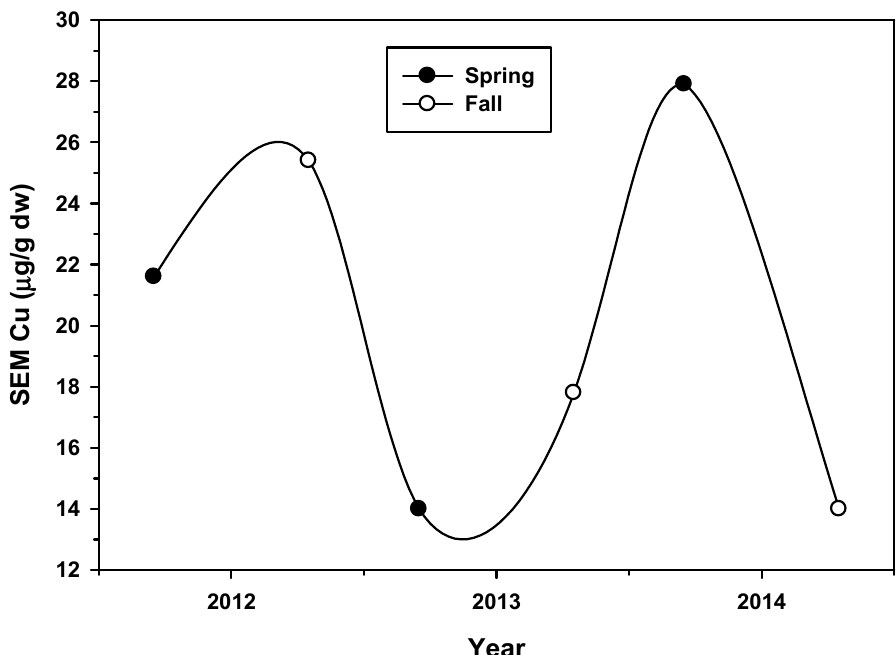
Figure 12. SEM copper concentrations (µg/g dry wt) from spring and fall sediment sampling at Cache Slough site CS-11 for the years 2012, 2013 and 2014.